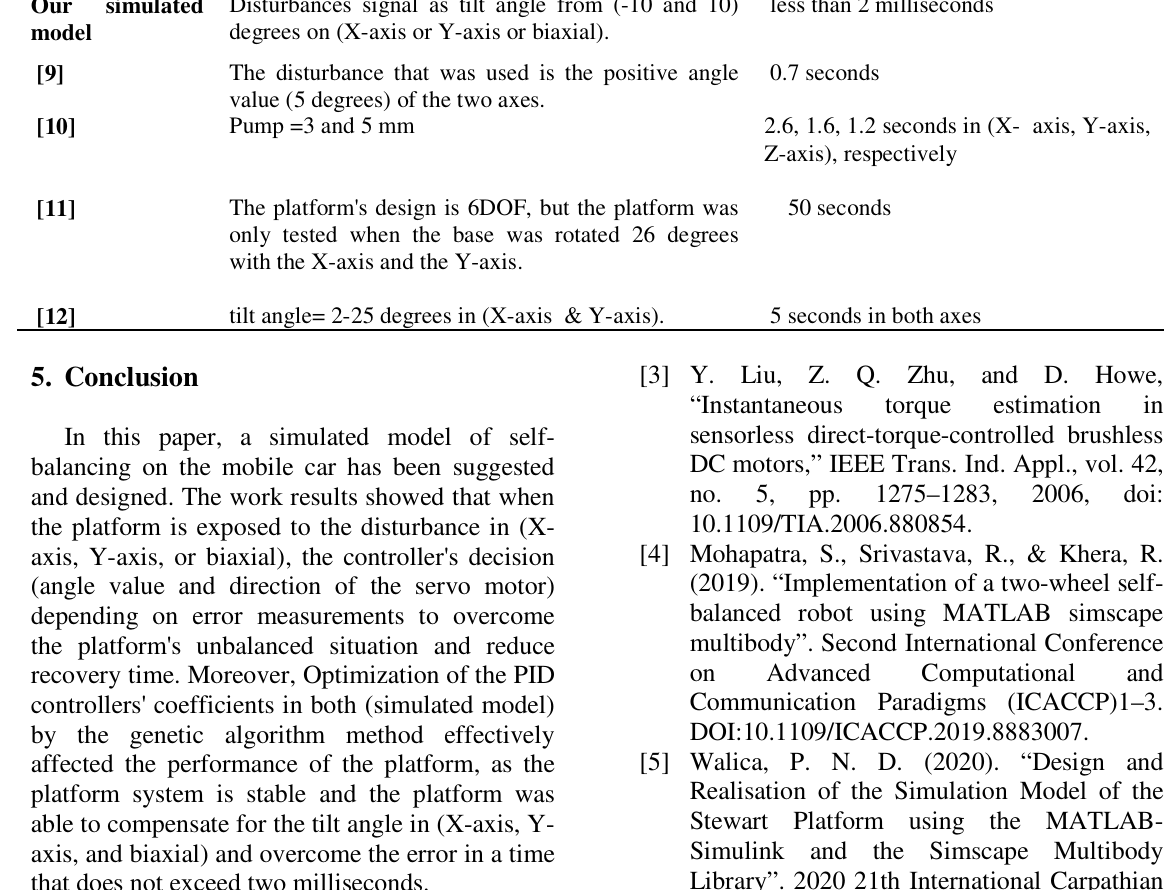
Comparison between our self-balancing platform on the mobile car with other article references . Disturbance type Self-balancing time Disturbances signal as tilt angle from (-10 and 10) Our simulated degrees on (X-axis or Y-axis or model